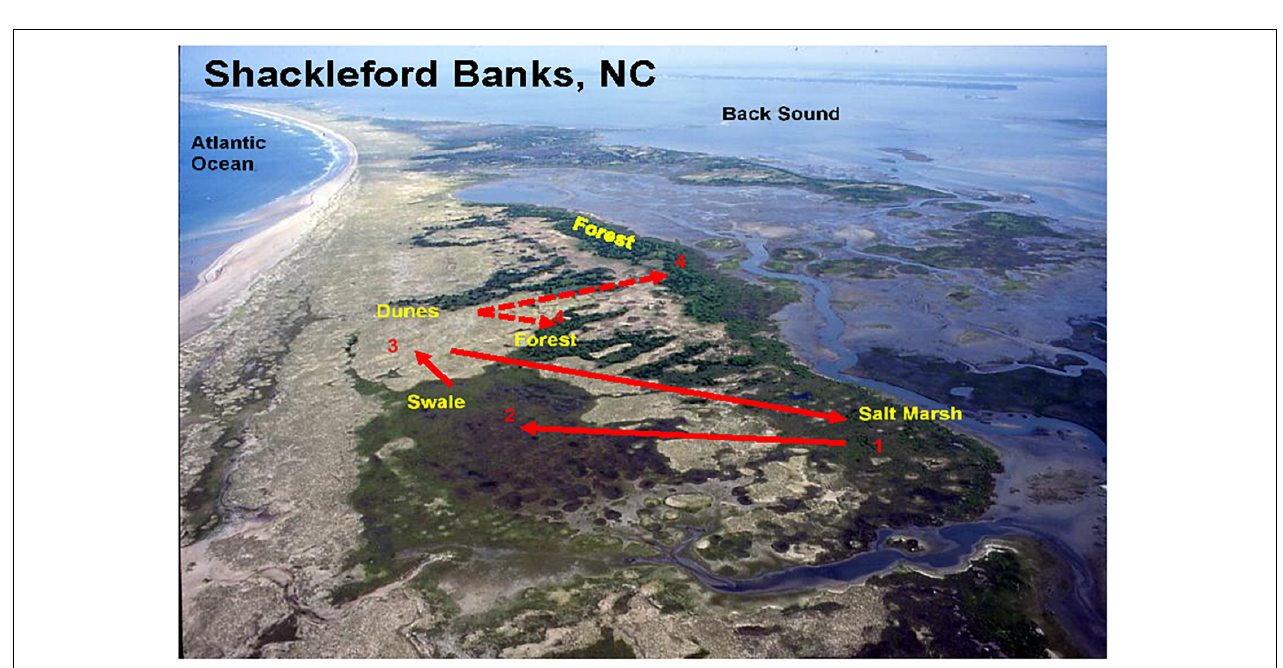
FIGURE 9 | Aerial view of the island showing that the major habitat types are distributed along the long axis of the island. The numbers connected by arrows depicts a typical “daily round” – the numbers depict the order in which the horses move among habitats: from the salt marshes (1) to the swales (2), to the dunes (3), and the forests (4). Solid lines show the normal movement order among habitats on days when wind speeds range from 1 to 15 km/h. Dotted lines represent occasional movements to forest habitats when wind speeds exceed 20 km/h.